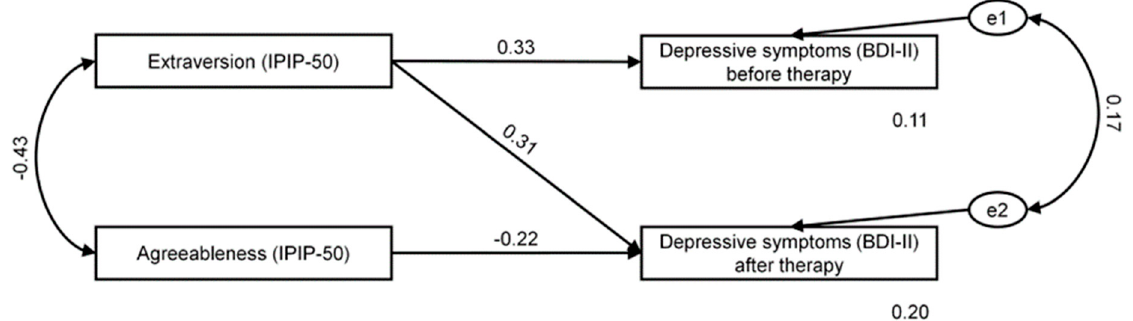
Figure 1. Extraversion and agreeableness as predictors of depressive symptoms in the investigated group before (T1BDI) and after (T2BDI) therapy. e1 and e2 depict the error term referring to the dependent variables.